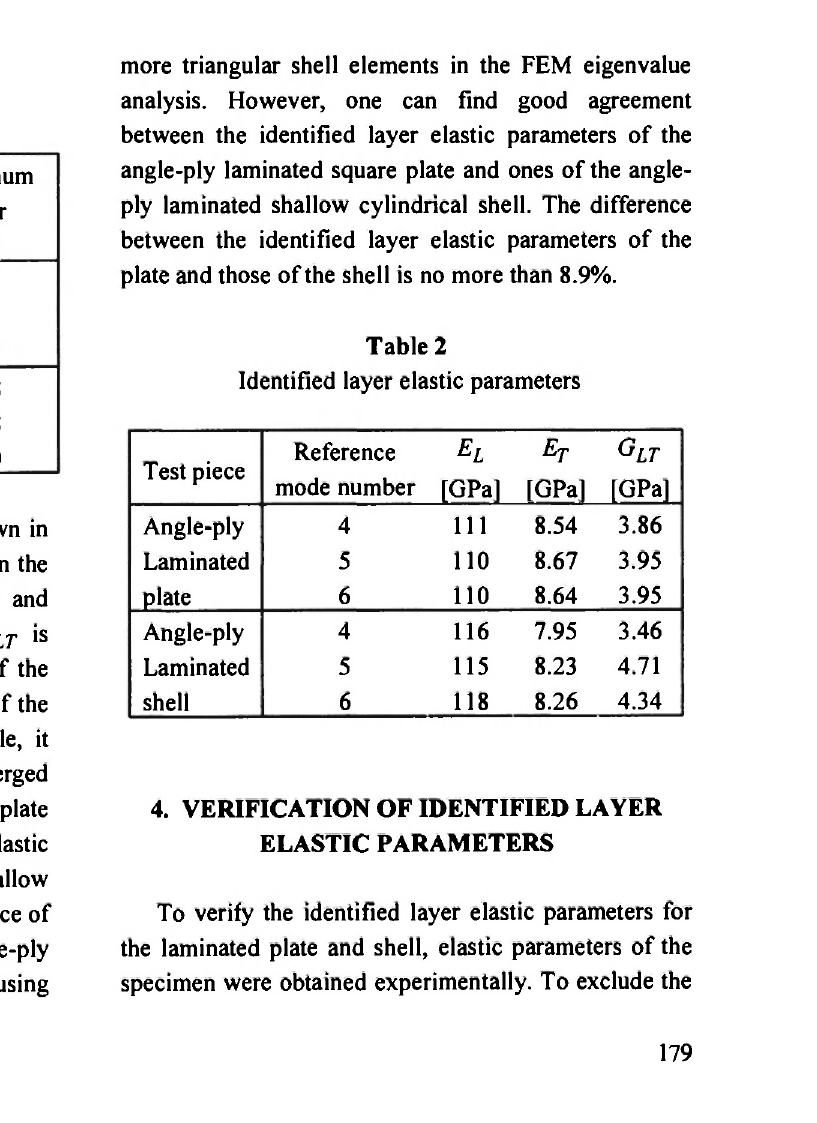
Fig. 4: Experimental natural frequencies and mode shapes of test pieces